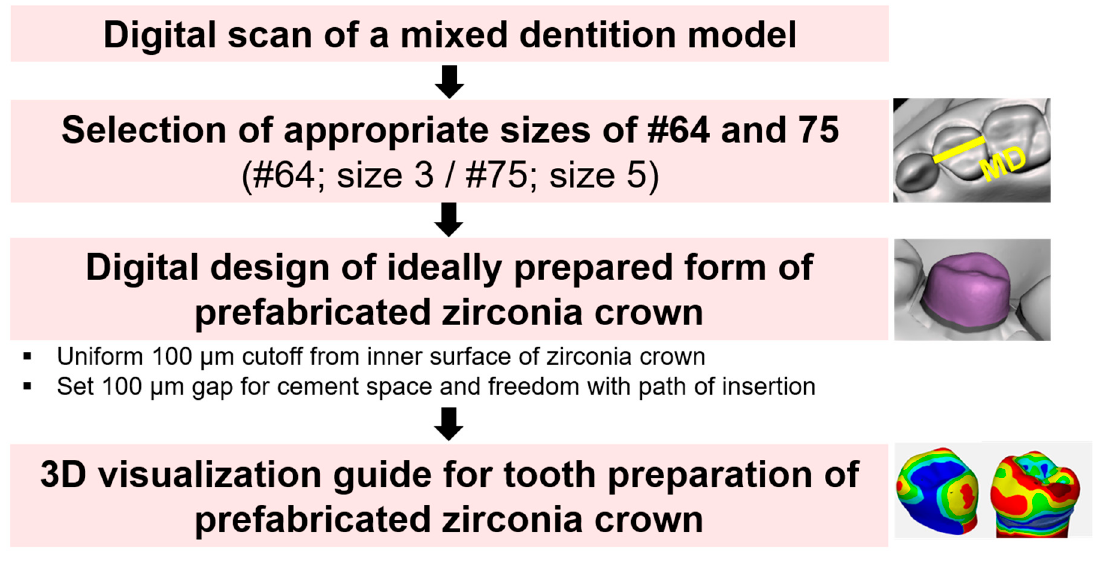
Figure 1. Digital workflow of the development of 3D-visualized data of the tooth preparation guide for prefabricated zirconia crowns (PZCs).